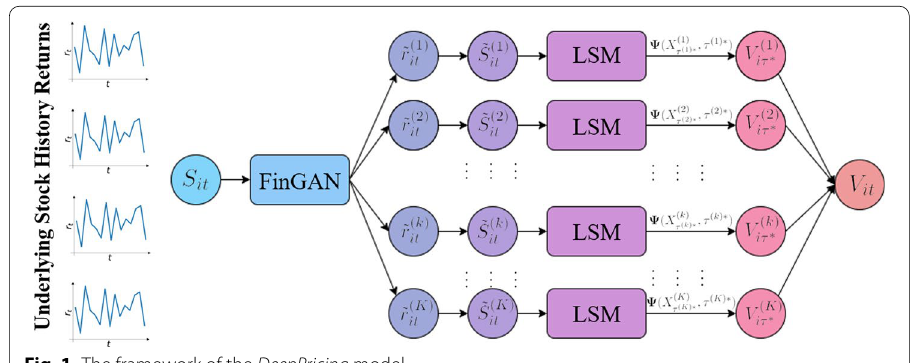
Fig. 1 The framework of the DeepPricing